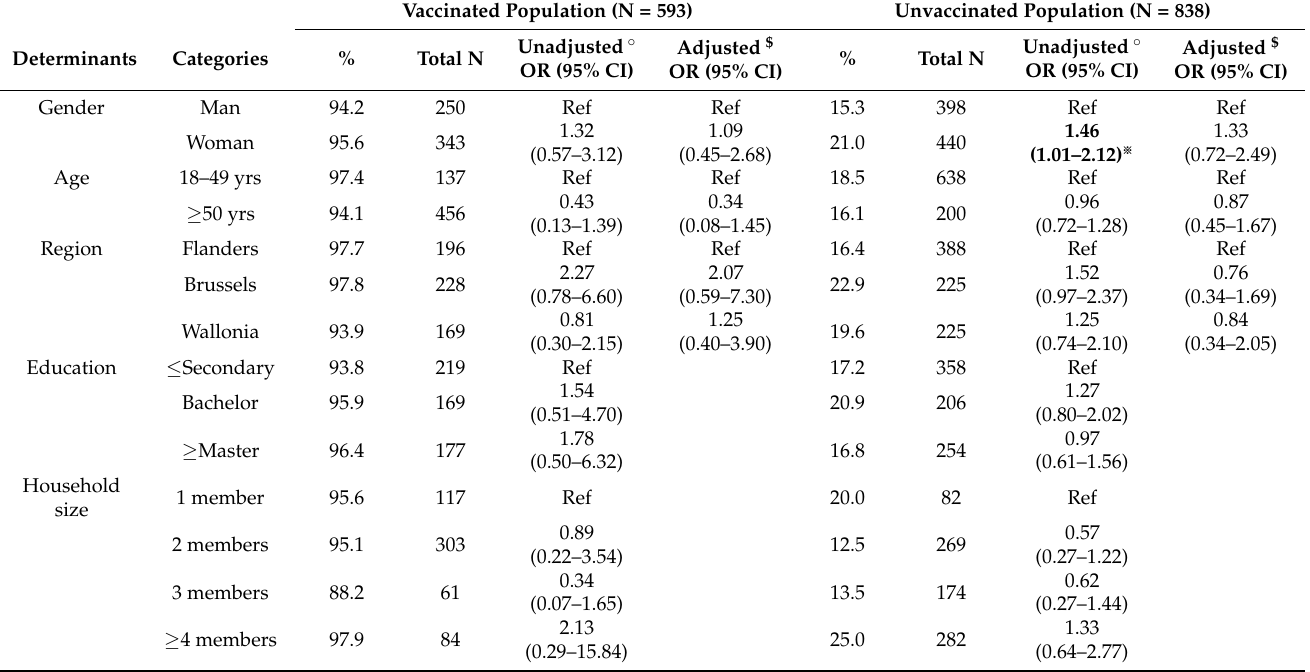
Table 3. Prevalence of anti-SARS-CoV-2 antibodies among vaccinated and unvaccinated populations and potential factors